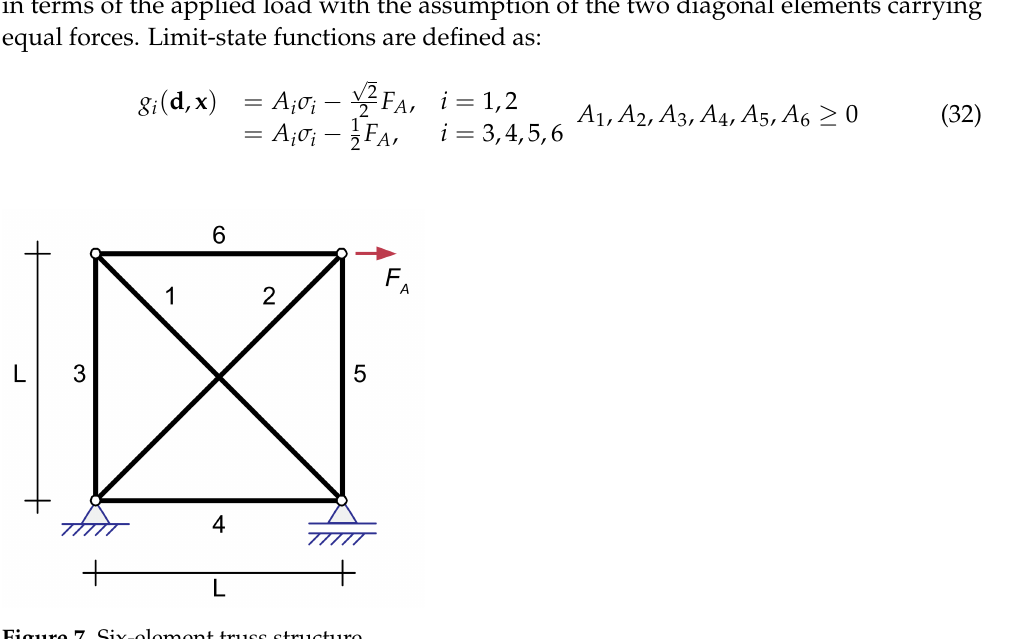
Figure 7. Six-element truss